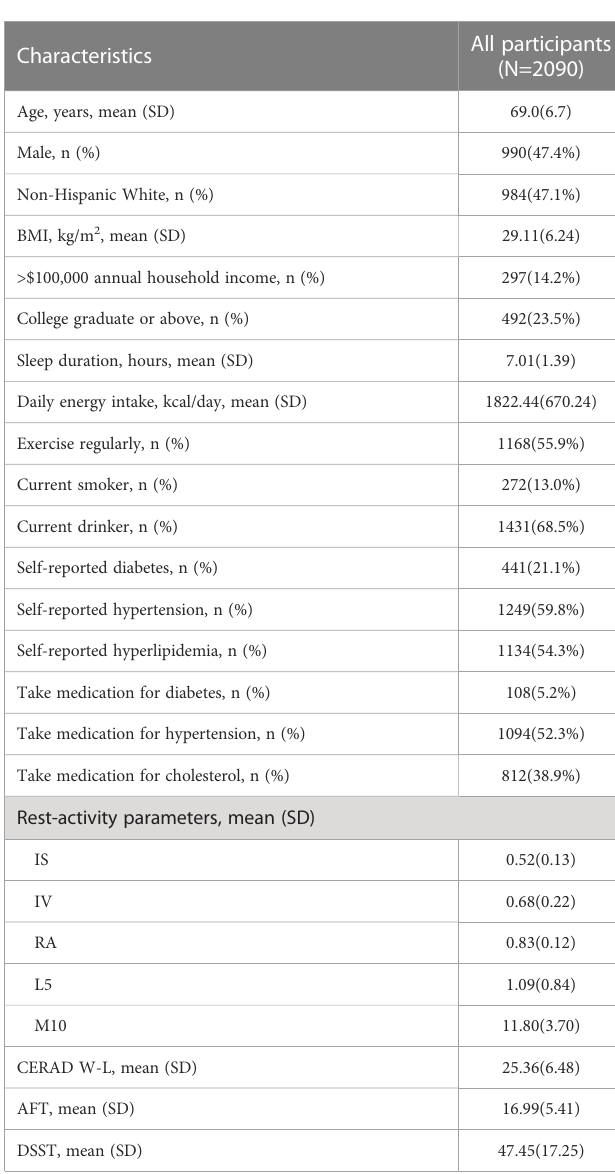
TABLE 1 Descriptive characteristics of the study sample, NHANES 2011-